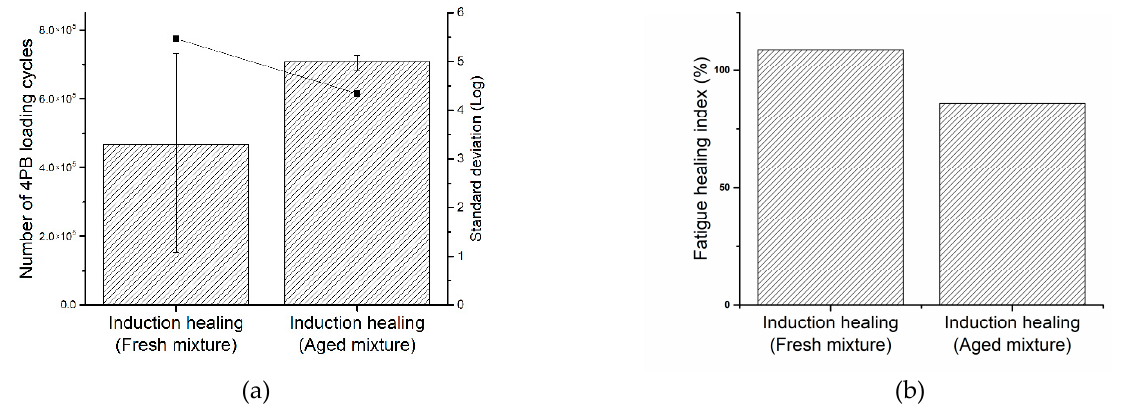
Figure 14. Four-point bending fatigue test results for the induction healing system in PA mixture with different ageing levels: ( a ) total number of 4PB fatigue loading cycles and ( b ) the fatigue healing index.